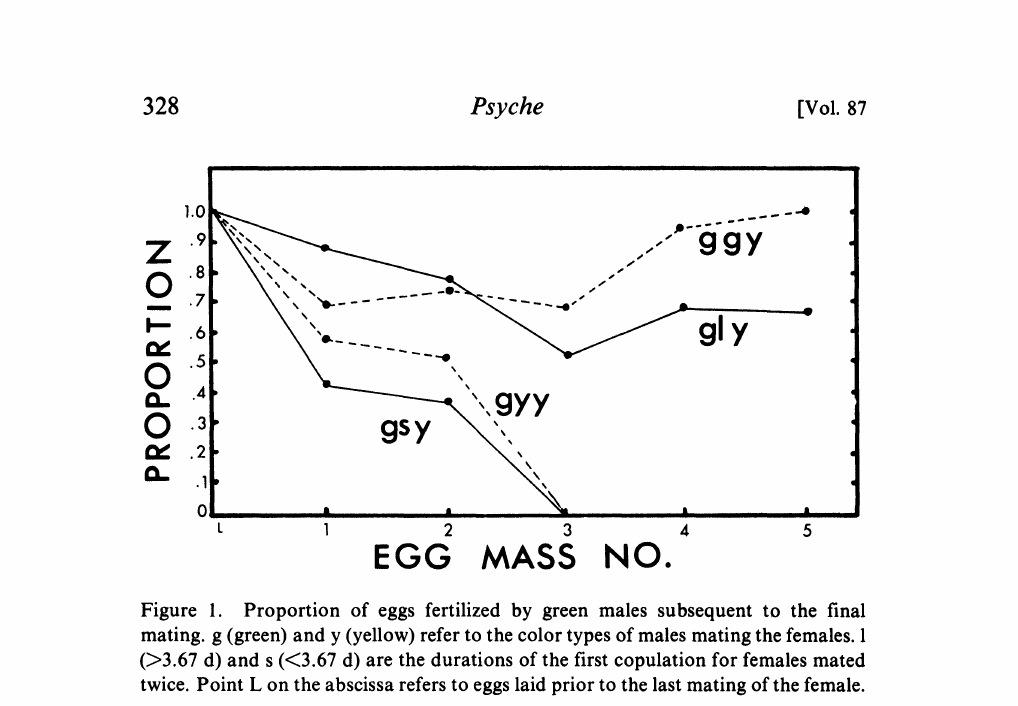
Figure 1. Proportion of eggs fertilized by green males subsequent to the final mating, g (green) and y (yellow) refer to the color types of males mating the females. (>3.67 d) and (<3.67 d) are the durations of the first copulation for females mated twice. Point L on the abscissa refers to eggs laid prior to the last mating of the